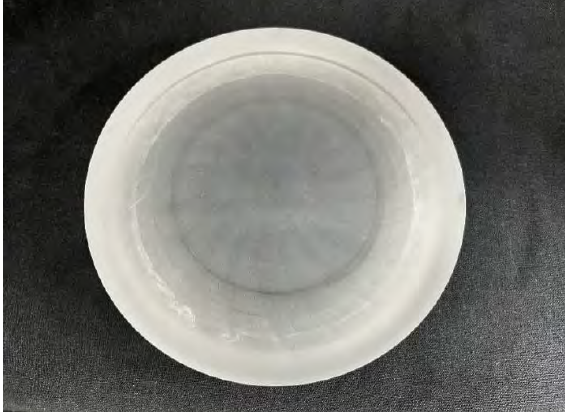
Fig . 3 . Sample of diameter 167 mm polished to the V-shape